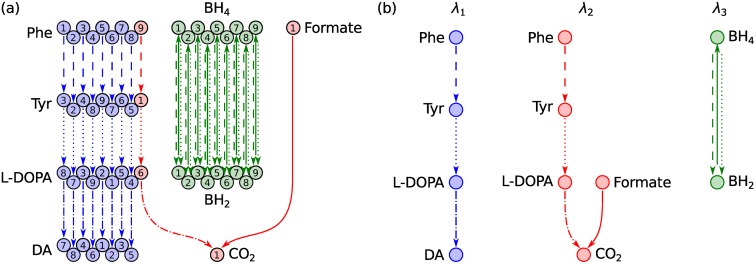
Identification of conserved carbon moieties in DAS.(a) The carbon atom transition network. Numbering of atoms and line styles of atom transitions refer to metabolite structures and reactions, respectively, in Fig 4. The directed graph consists of 18 components, one for each of the nine carbon atoms in L-phenylalanine, and one for each of the nine carbon atoms in tetrahydrobiopterin. The single carbon atom (C1) in formate is in the same component as C9 in L-phenylalanine, since a path can be traced between the two atoms when directionalities of atom transitions are ignored. Isomorphic components have matching colours. A single instance of a conserved moiety consists of all equivalent atoms in a set of isomorphic components. (b) Moiety graphs for the three carbon moieties in DAS. Each graph was obtained by merging a set of isomorphic components in (a) into a single directed graph. Each node represents an instance of a conserved moiety. Each edge represents conservation of a moiety between two metabolites in a particular reaction in Fig 4 with matching line style. Colours match the background colours of the corresponding moieties in Fig 4. Analysis of the full atom transition network for DAS yielded four additional conserved moieties (Fig 6).